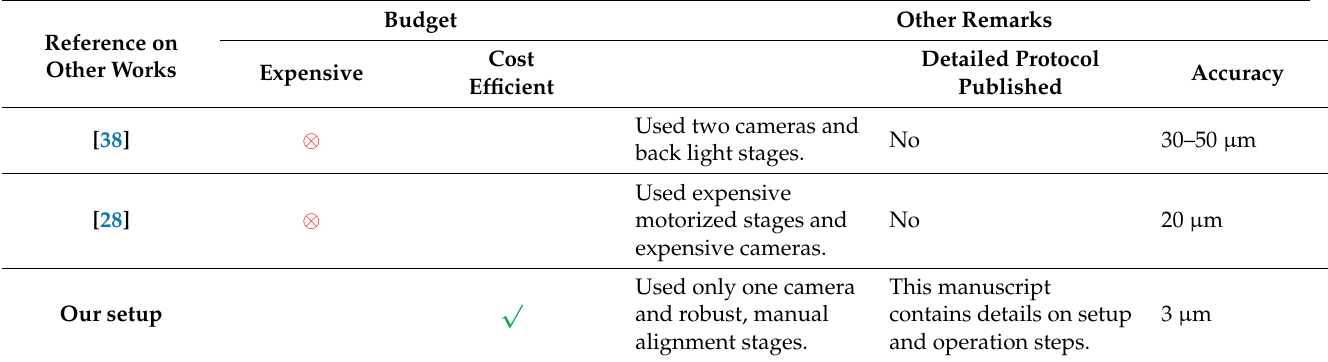
Figure 5. Microscope image of the microstructures inside the microfluidic chips after alignment and bonding. The alignment accuracy is up to 3 microns, which is much more precise compared to other reported experiments (shown in Table 1).